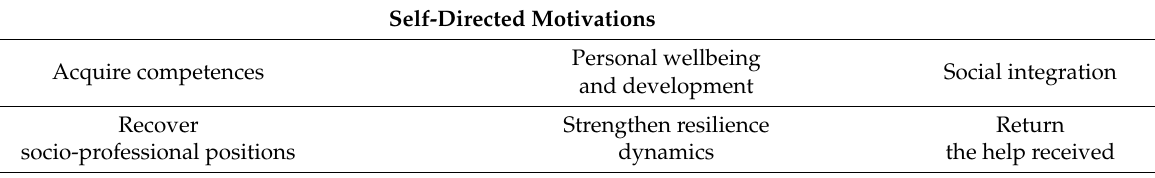
Table 2. Motivations and types of volunteering and social engagement